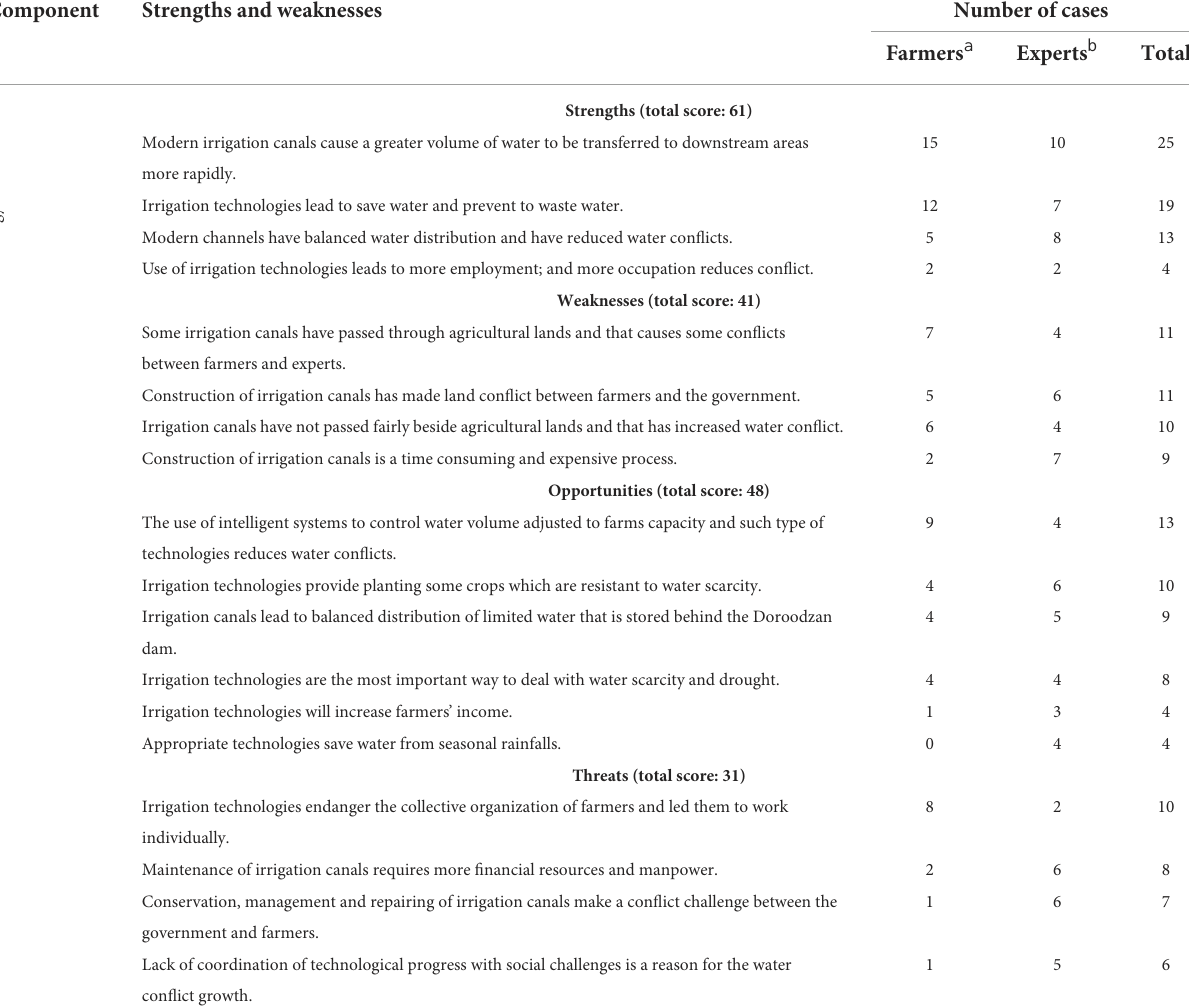
TABLE 10 SWOT matrix of technology with water conflict: Opinions of farmers and experts. Component Strengths and weaknesses Number of cases